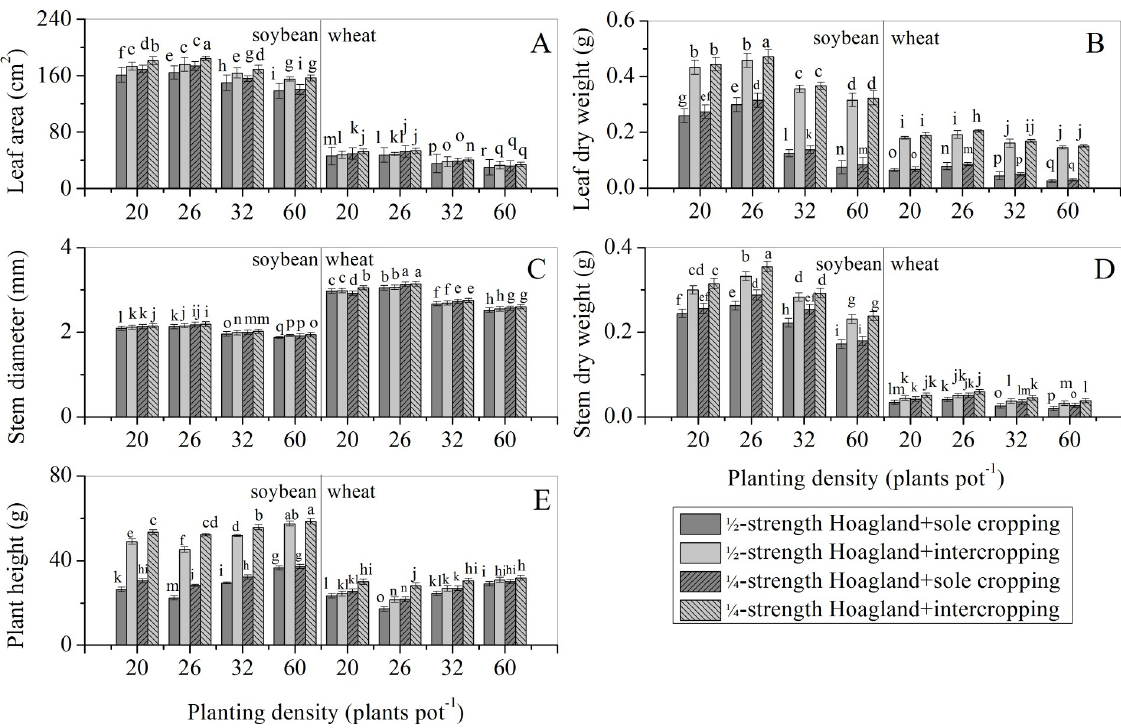
Fig 1. Effects of nutrient level and planting density on aboveground modules of soybean/wheat sole cropping and intercropping populations. Data are expressed as means ± standard errors of five replicates, and the error bars represent standard errors. Treatments marked with the same letter are not significantly different according to Fisher’s LSD test ( p <